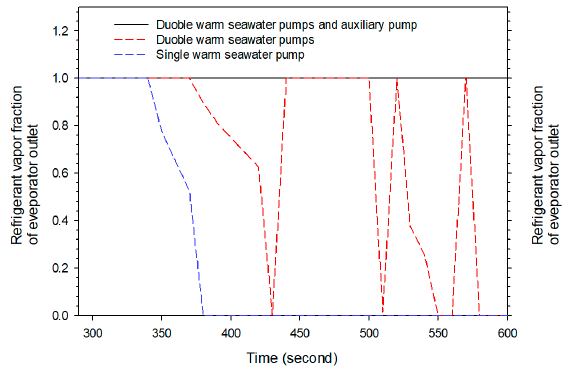
Figure 11. Vapor fraction of the refrigerant according to the type of heat pump used.